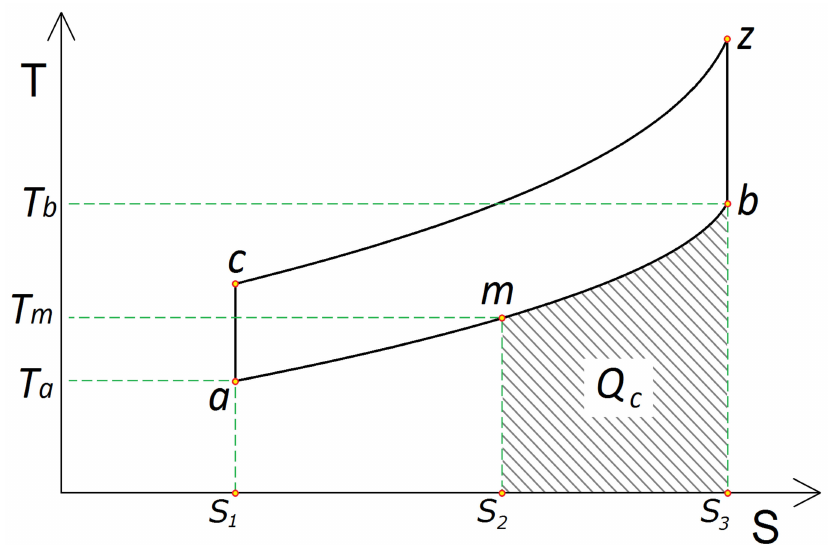
Figure 2. Thermodynamic cycle for diesel engines converted to gaseous products of methanol conversion with heat regeneration. S 1 -c-z-S 3 —the supplied heat Qs ; S 1 -a-b-S 3 —the waste heat Q W ; S 2 -m-b-S 3 —the heat conversion suitable for regeneration